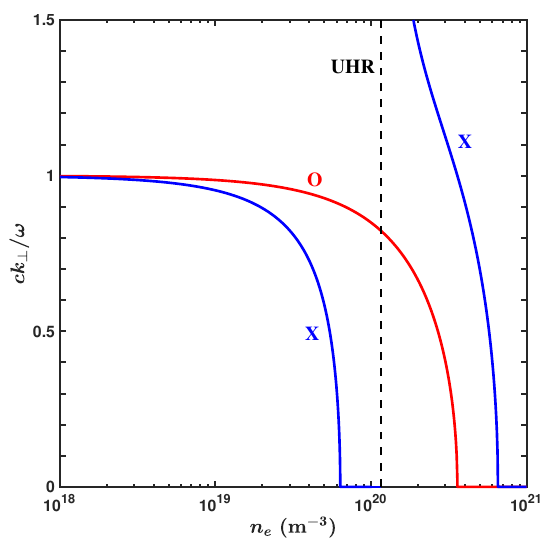
Figure 2. Dispersion properties of EC waves obtained from D (cid:0) k ⊥ , k (cid:107) ,ω (cid:1) = 0: ck ⊥ /ω is plotted as a function of the electron density for f = ω/ 2 π = 170 GHz, B 0 = 5 T, and k (cid:107) = 0. The labels indicate the extraordinary X mode, the ordinary O mode, and the upper hybrid resonance UHR. The X mode is cuto ff at n e ≈ 6 . 34 × 10 19 m − 3 , the UHR is located at n e ≈ 1 . 15 × 10 20 m − 3 , the O mode is cuto ff at n e ≈ 3 . 58 × 10 20 m − 3 , and the sec- ond X mode is cuto ff at n e ≈ 6 . 53 × 10 20 m − 3 .